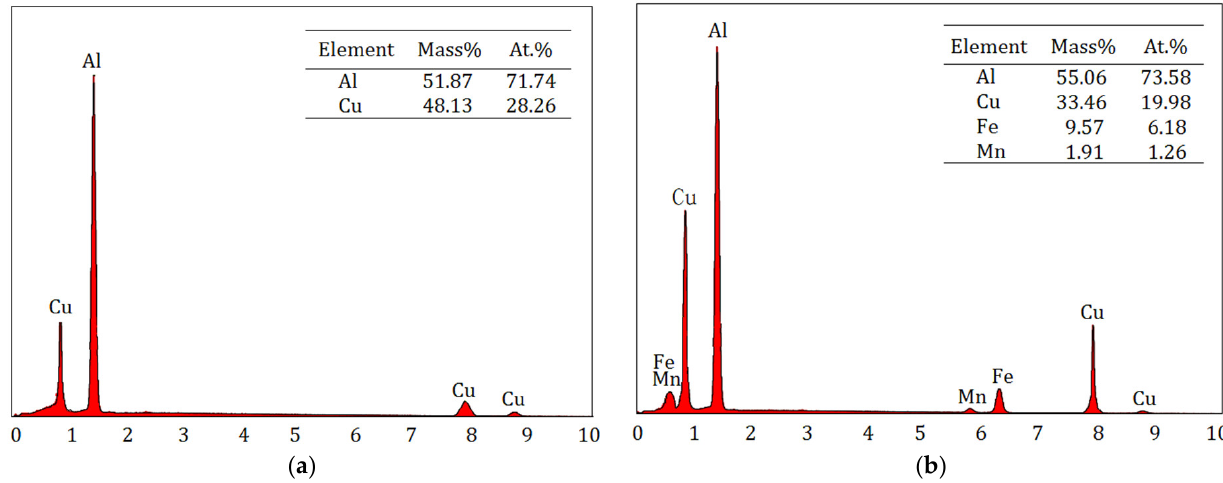
Figure 3. Energy dispersive X-ray spectrometer (EDS) of the second-phase particles in as-cast 0.15 wt.% Fe alloy: ( a ) Point A (Al 2 Cu) and ( b ) Point B (Al 7 Cu 2 (Fe, Mn)).